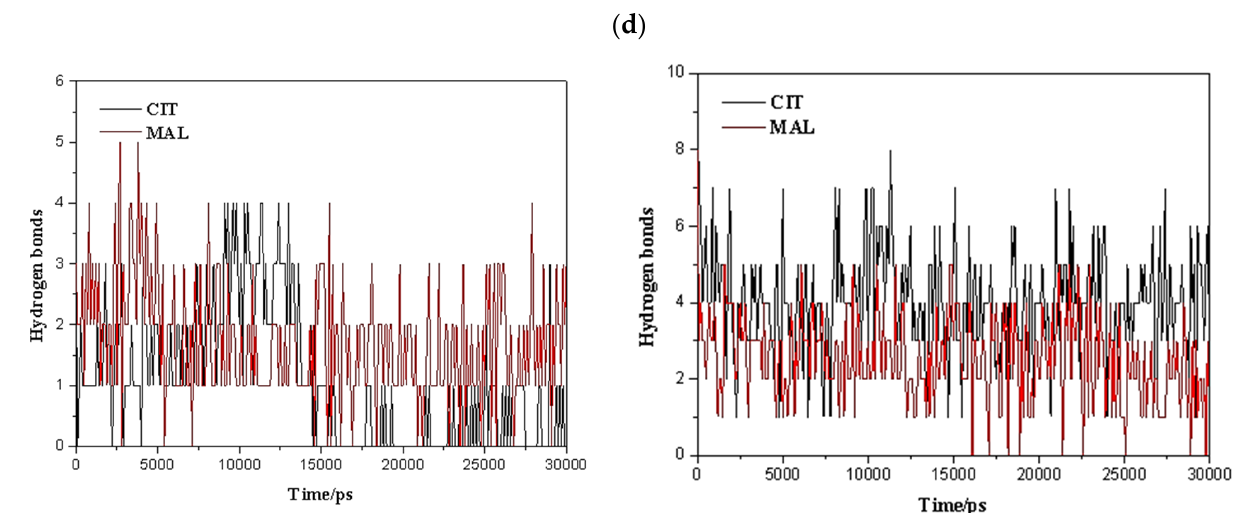
Figure 7. Molecular dynamics simulations showing a stable protein complex. ( a ) The root means square deviation (RMSD) of MT-CIT and MT-MAL (left) and SoDIT-a-CIT and SoDIT-a-MAL (right) in the complex over 10 ns in comparison with values for the unbound (free) proteins. ( b ) The radius of gyration versus time for protein transporter molecules in self-association simulations. ( c ) The difference in RMSF between bound and free proteins. ( d ) Number of hydrogen bonds between protein(s) and ligand(s) during the simulation period.